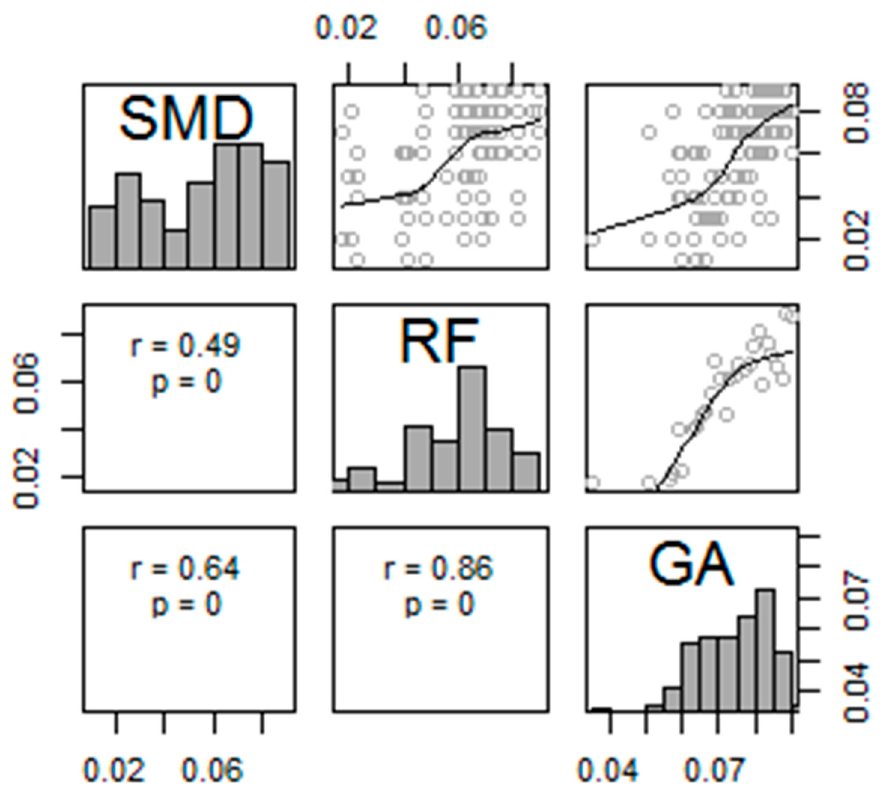
Figure 4. Correlation matrix plot between RFs, GALTS and PDM SMD during validation (the black line indicates the fitting line and the histogram shows the variation of the particular parameter).